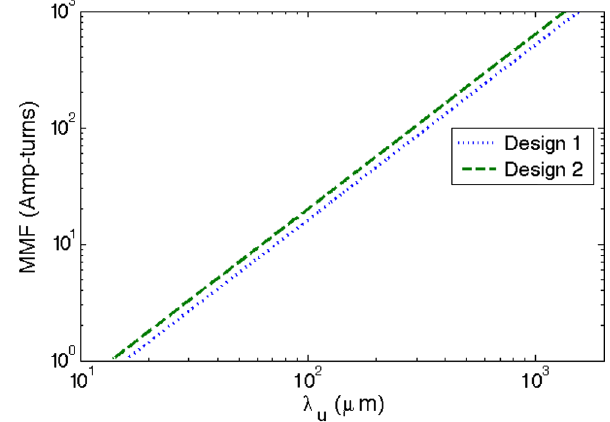
FIG. 6. Plot showing the ratio of the MMF required to saturate the magnetic yoke, normalized to 1 T, for a variety of undulator geometries.